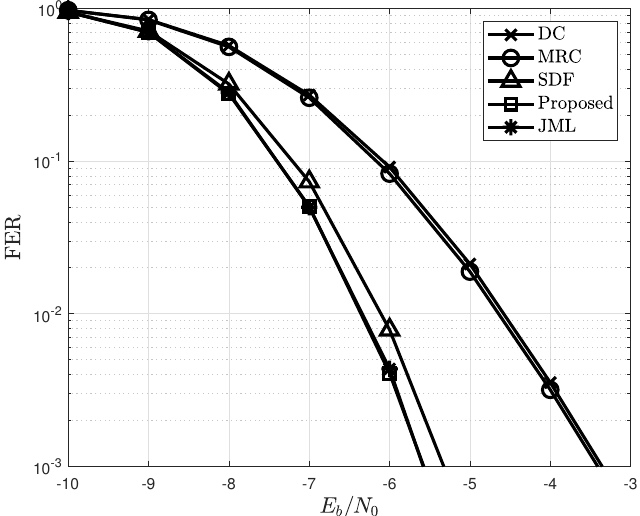
Figure 5. FER of the proposed detection with different detection schemes when ( N S , N R , N D ) = ( 2,8,8 ) .